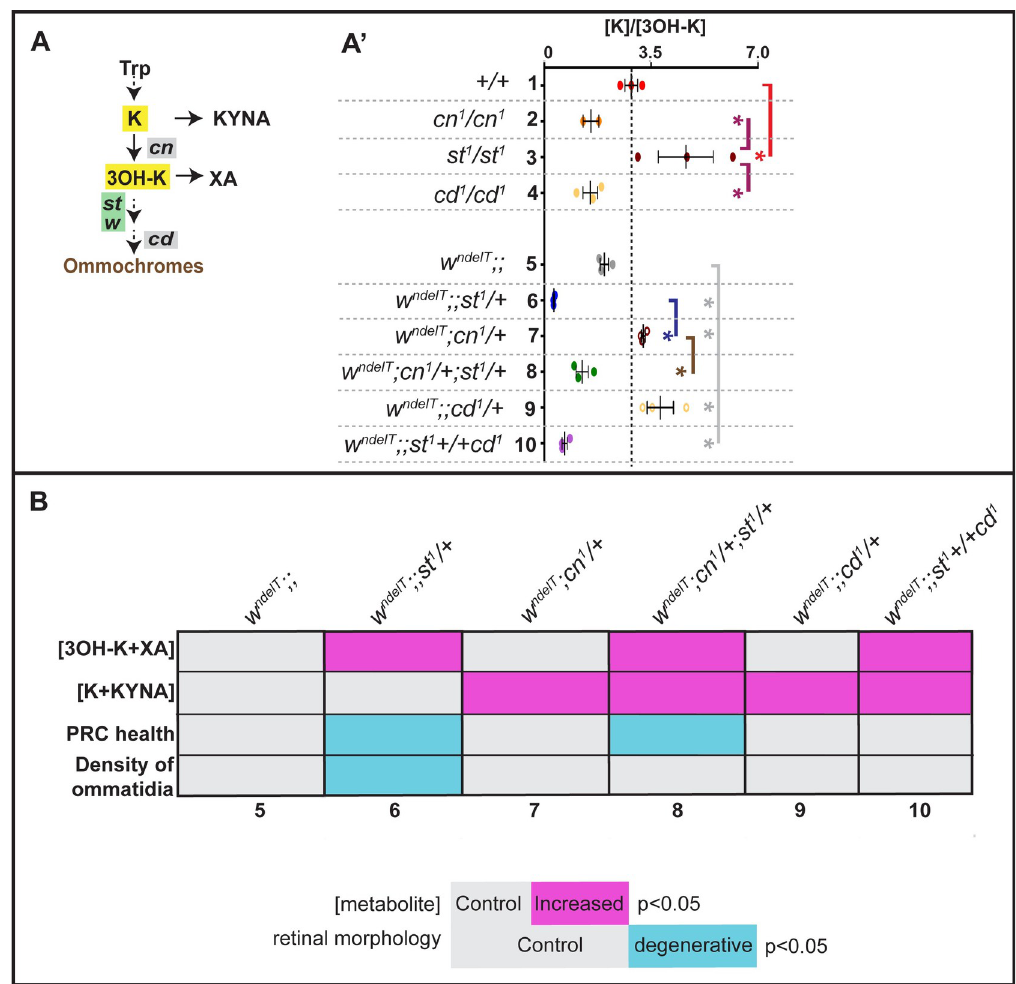
Fig 3. Increased 3OH-K abundance is associated with extensive light-induced retinal damage. A: Schematic outline of relevant steps in the Kynurenine pathway (KP) and brown pigment biosynthesis. Genes used in this study are indicated. A’: Graph depicting the ratio of the abundances of Kynurenine and 3-hydroxykynurenine [K]/[3OH-K] (highlighted in yellow in the corresponding pathway shown in A-D) from MS measurements of head extracts of flies kept under physiological/non degenerative light conditions. Numbers on Y-axis correspond to the genotypes listed to the left. Each colored dot represents an individual biological replicate of 10 pooled heads. Statistical comparisons between genotype pairs are indicated with solid lines (red line compared to +/+ , magenta line compared to cn 1 /cn 1 , grey line compared to w ndelT , blue line compared to w ndelT ;;st 1 /+ , brown line compared to w ndelT ;cn 1 /+ ) with � revealed by ANOVA followed by Bonferroni’s post-hoc test at p < 0.05. B: Tabular summary of various parameters (horizontal lines) with different genotypes (columns 5–10, corresponding to genotypes shown in the table in A’). The parameters include metabolite levels (top two) and retinal health indicators (bottom two). For metabolite levels, grey colored cells imply no difference from controls ( w ndelT ), cells colored magenta imply significantly higher metabolite levels. For retinal health indicators, grey colored cells imply no difference from controls ( w ndelT ), cells colored cyan imply significantly reduced ommatidial density (number of identifiable ommatidia per unit area) or PRC health (percent frequency of surviving rhabdomeres). Statistical significances were calculated with ANOVA followed by Bonferroni’s post-hoc test at p <